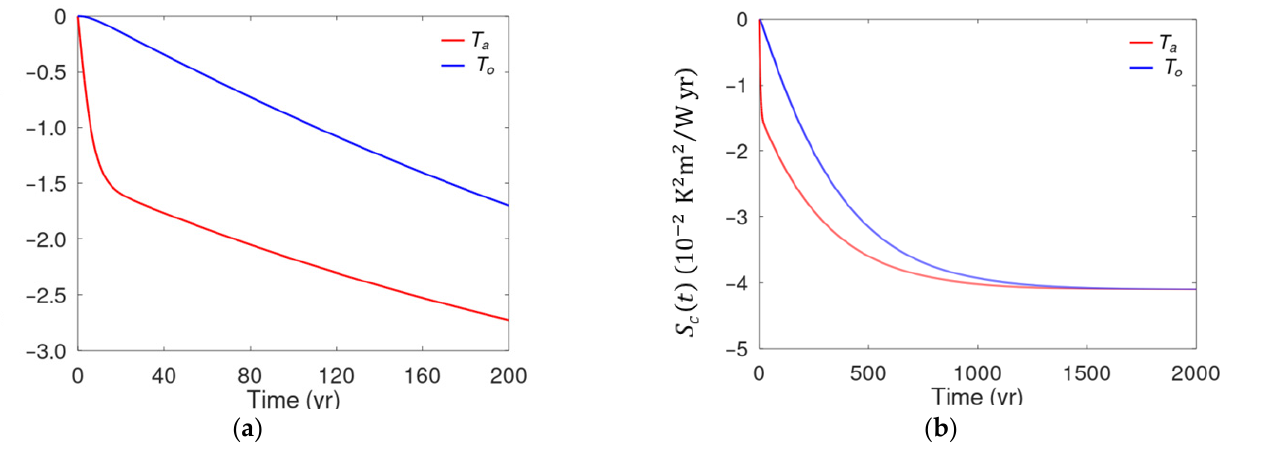
Figure 5. Global mean surface temperature (red line) and global mean deep ocean temperature (blue line) calculated for linear forcing.